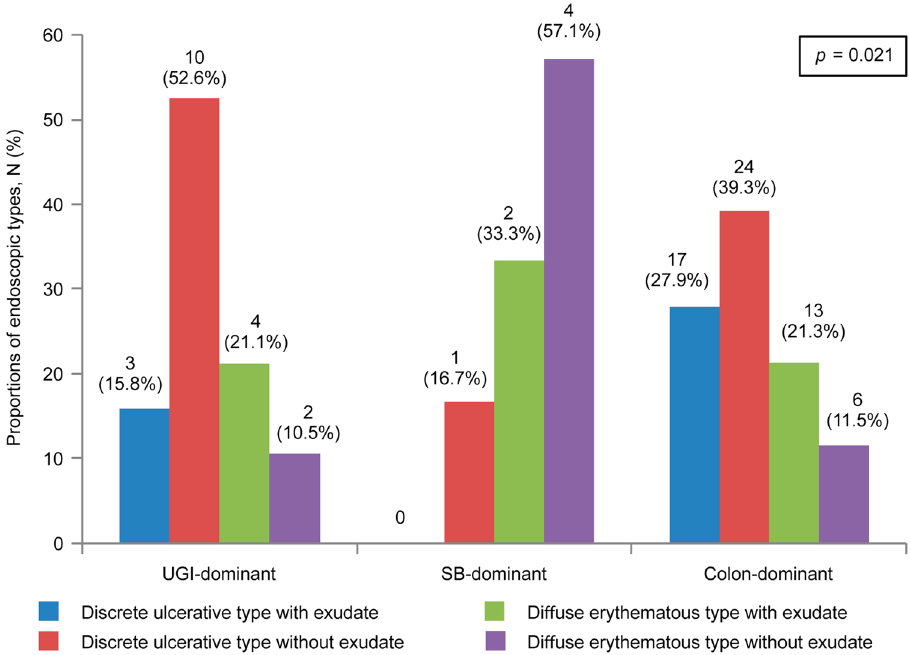
Figure 3. Proportions of endoscopic types according to sites of cytomegalovirus involvement. UGI, upper gastrointestinal tract; SB, small